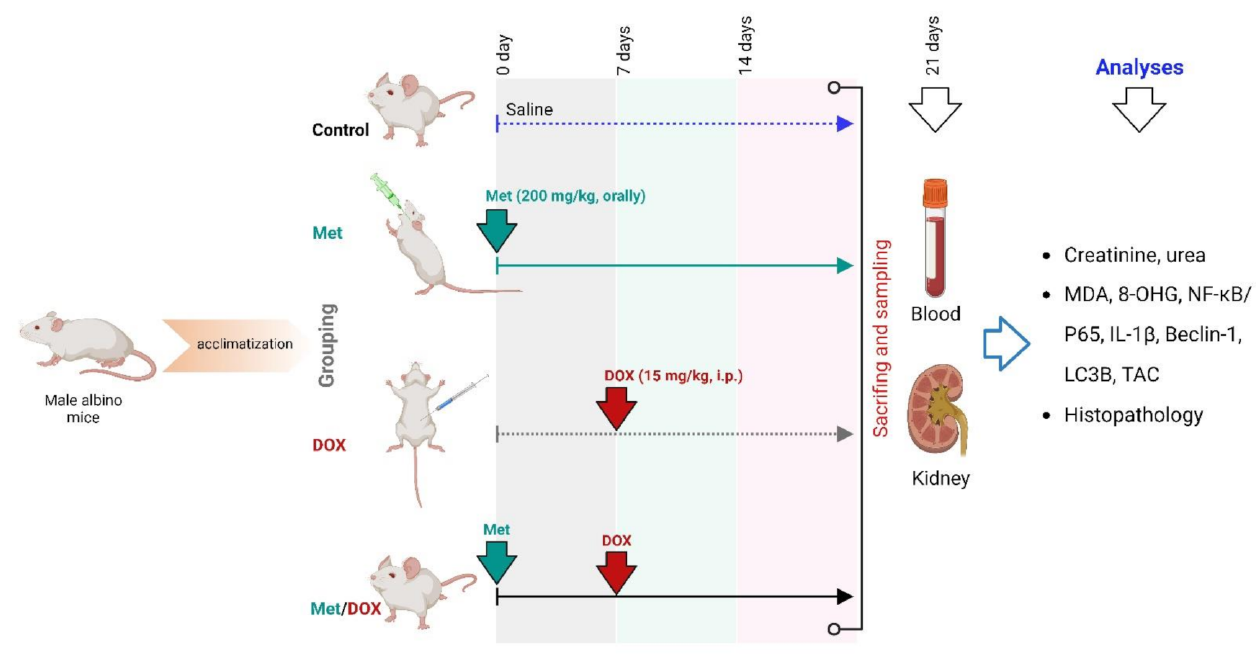
Figure 10. Experimental